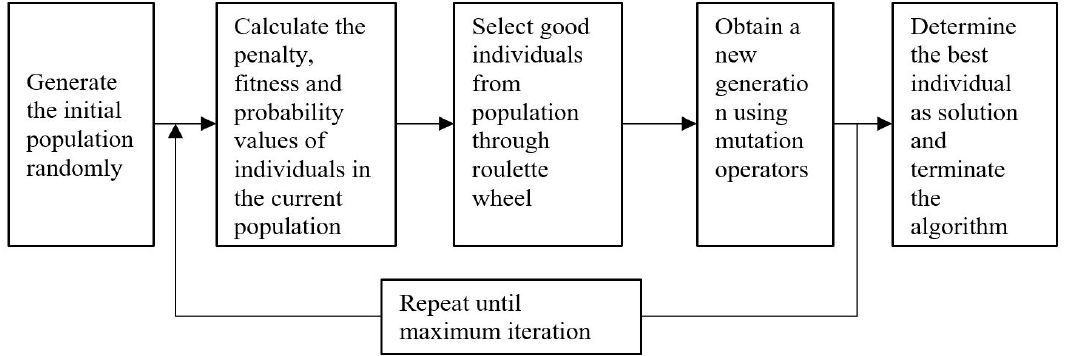
Figure 14. Proposed genetic algorithm [33].